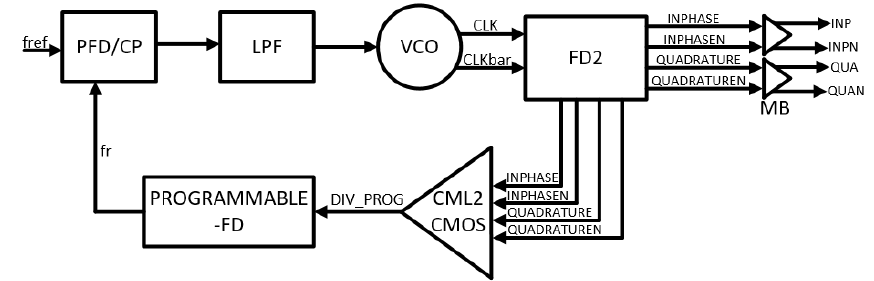
Figure 1. Frequency synthesizer block